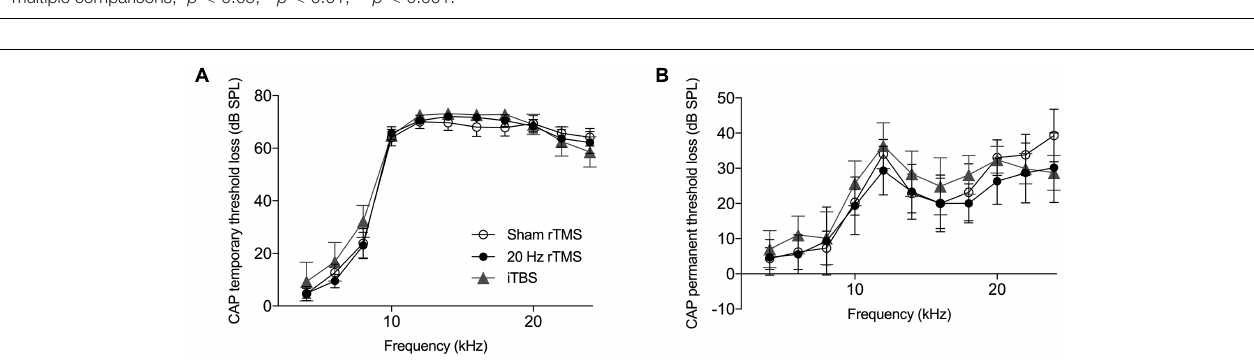
FIGURE 3 | Active rTMS ameliorates behavioral signs of tinnitus. (A) The percentage PPI at the frequency of tinnitus development. Mean percentage PPI is significantly different between pre-trauma and post-trauma time points ( p < 0.0001). (B) The percentage GPIAS at the frequency of tinnitus development. For the three animals that developed GPIAS deficit at both 8 and 14 kHz, the average PPI and GPIAS for both frequencies was calculated. Graphs show the data before acoustic trauma (pre-trauma), at the time-point of tinnitus development (post-trauma), and after treatment on the day of final electrophysiological recordings (post-treat; GPIAS data only) for Sham rTMS ( n = 6), 20 Hz rTMS ( n = 6), iTBS ( n = 7). All data mean + SEM, two-way repeated measures ANOVA with Tukey multiple comparisons; * p < 0.05, ** p < 0.01, *** p < 0.001.